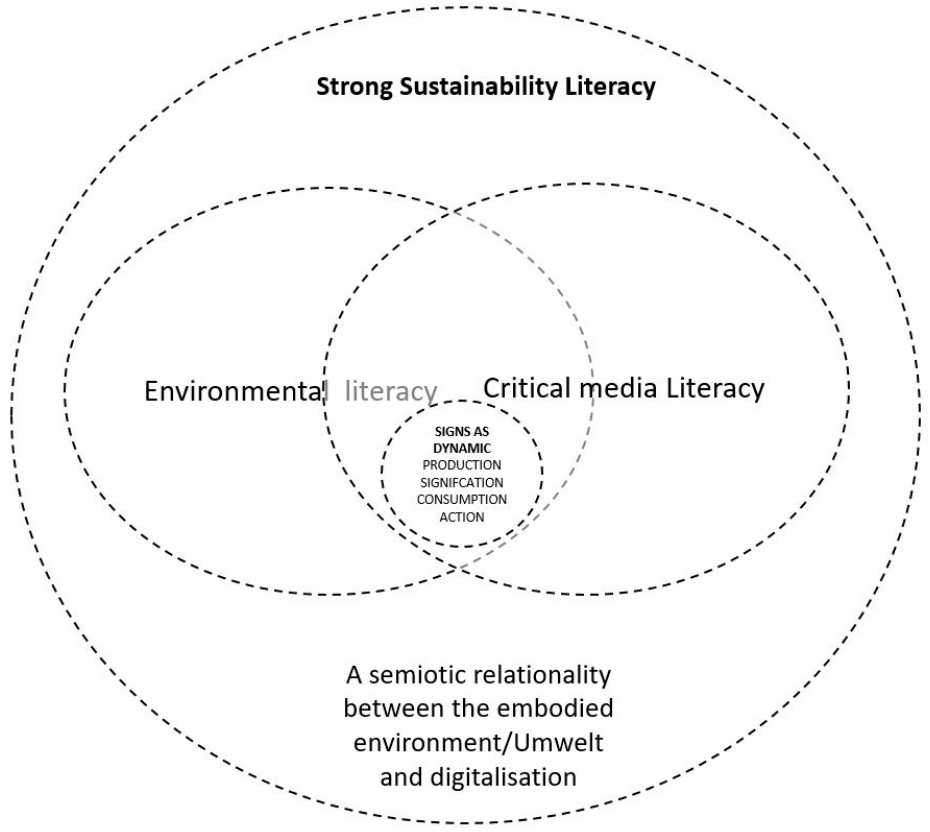
Figure 2. A model of the field of strong sustainability literacy.